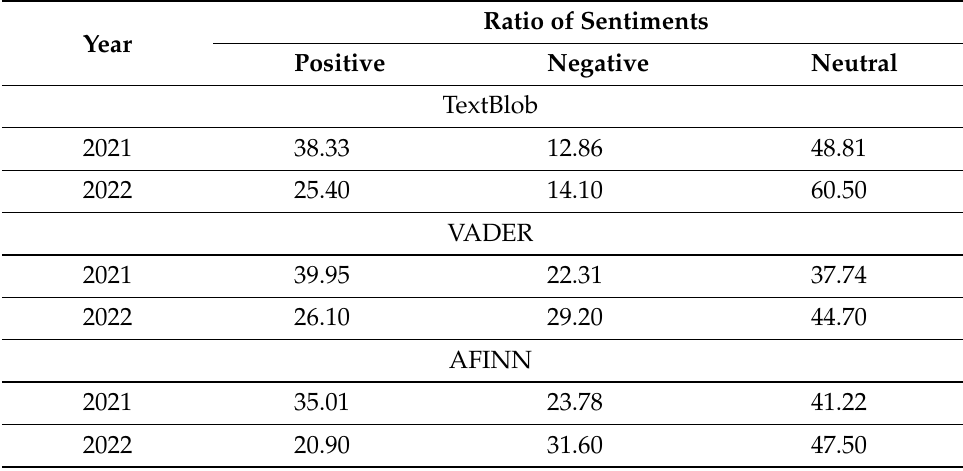
Table 19. Comparison of change in the sentiments over